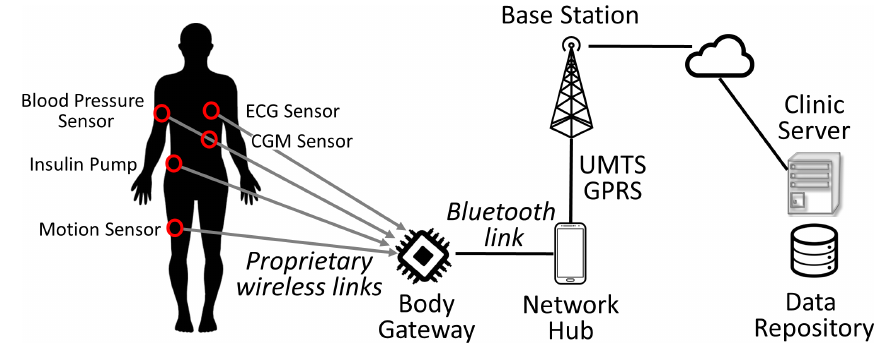
Figure 3. The architecture adopted for a Body Area Network sees multiple wearable devices coordinated by a Body Gateway . The Body Gateway interacts using Bluetooth with the Network Hub that enacts remote